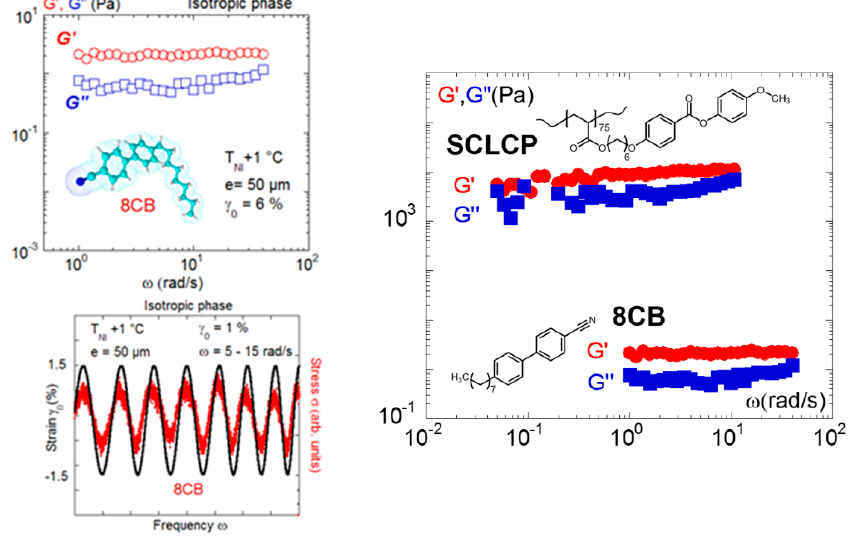
Figure 9. The solid-like dynamic response was highlighted in the isotropic phase of various liquid crystals including low molecular weight liquid crystals. The right figure shows superposed strain/stress waves measured on 8CB at T = T NI + 2 °C (phase sequence: K–21 °C–S A − 33 °C–N–40 °C–I) and 0.050-mm gap thickness (reproduced with permission from reference [34]). The left figure compares the elastic responses identified in LCPs with 85 repetitive units (phase sequence: Tg–22 °C–S A –89 °C–N − 116 °C) and 8CB, illustrating that the branched architecture reinforces the elastic response (reproduced with permission from [36,49]). The solid-like responses are measured at comparable thicknesses (0.050 mm and 0.060 mm).